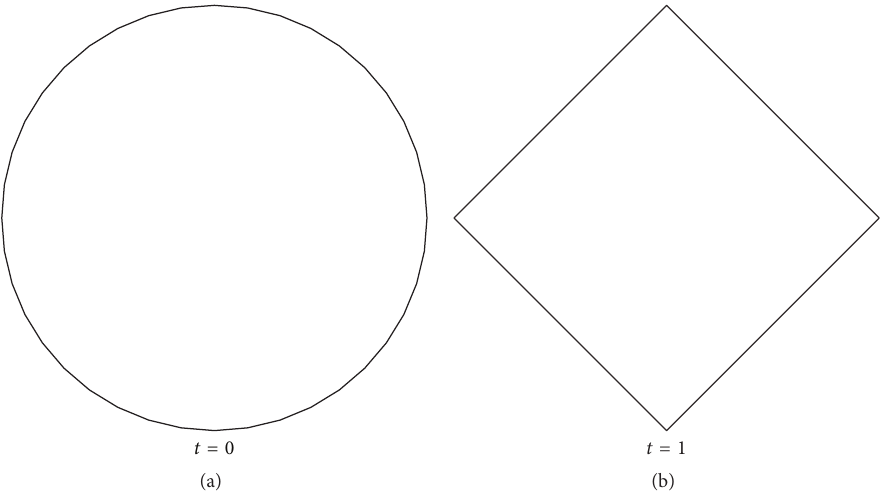
Figure 1: Source shape and destination shape. (a) Source. (b) Destination.